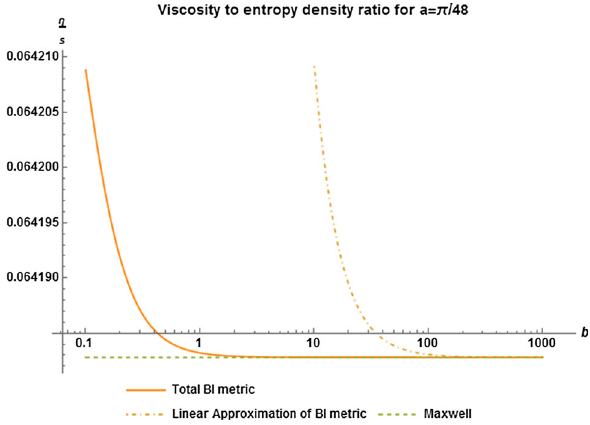
Fig. 3 Viscosity to entropy ratio for small charge regime